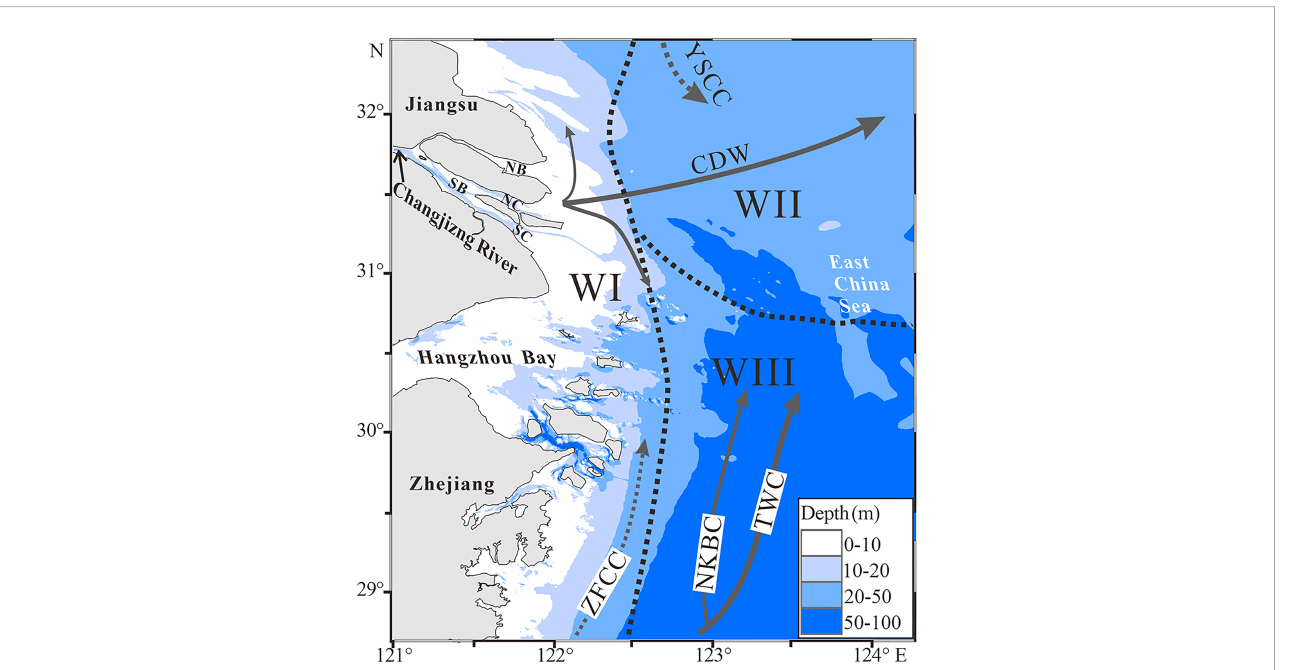
FIGURE 6 General current circulations (Su and Yuan, 2005; Guan and Fang, 2006; Yang et al., 2018) and the distribution of water masses in coastal sea off the Changjiang Estuary in summer. WI: low BWS and high BWT and DO water mass, WII: high BWS and DO and low BWT water mass, and WIII: high BWS and low BWT and DO water